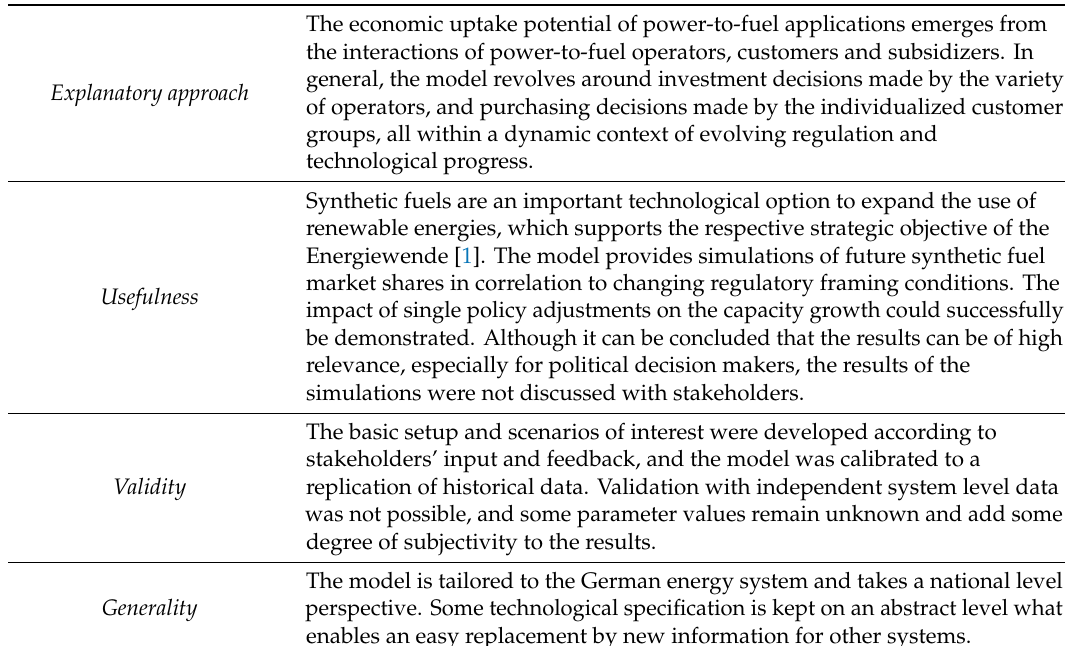
Table 4. Overall summary and assessment of case 4 (power-to-fuels) with regard to explanatory approach, usefulness, validity and